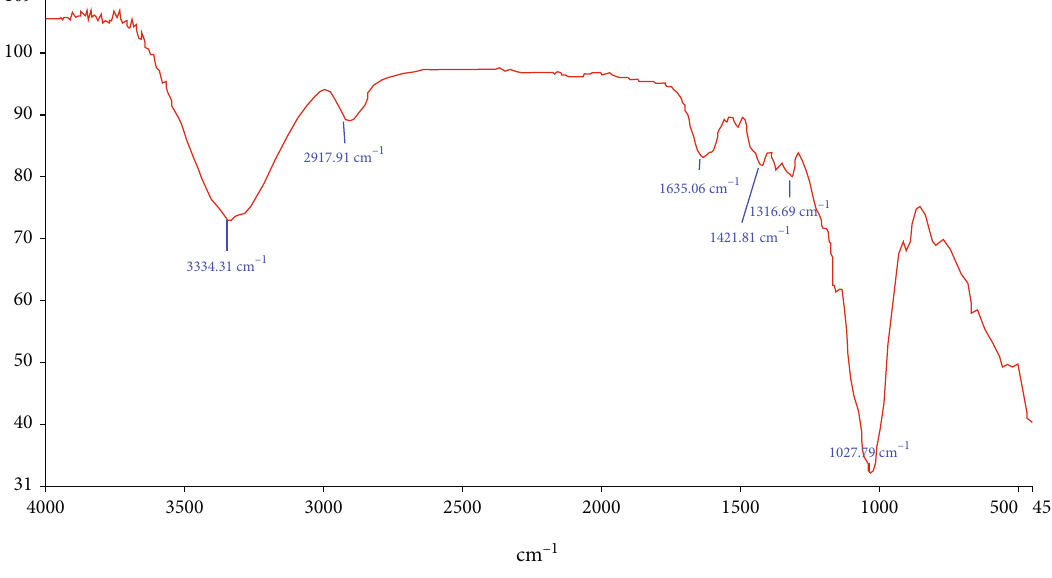
Figure 3: Infrared spectroscopy of rice husk sample treated with NaOH before adsorption. Table 2: Main functional groups in rice husk treated with NaOH before